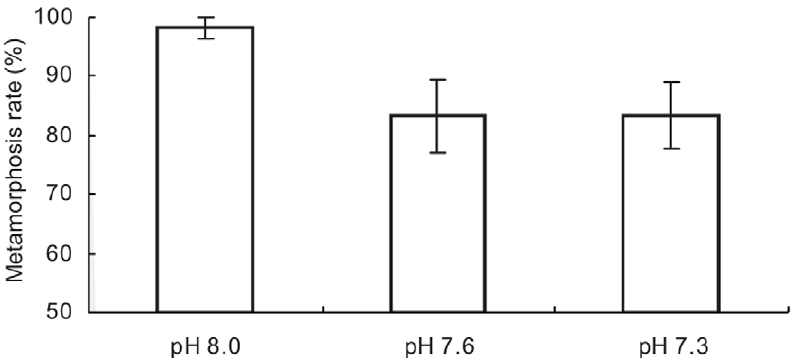
Figure 4. Metamorphosis rate of larvae of Acroporadigitifera after two-hour exposure to three different pH conditions. Bars indicate means and standard errors ( n